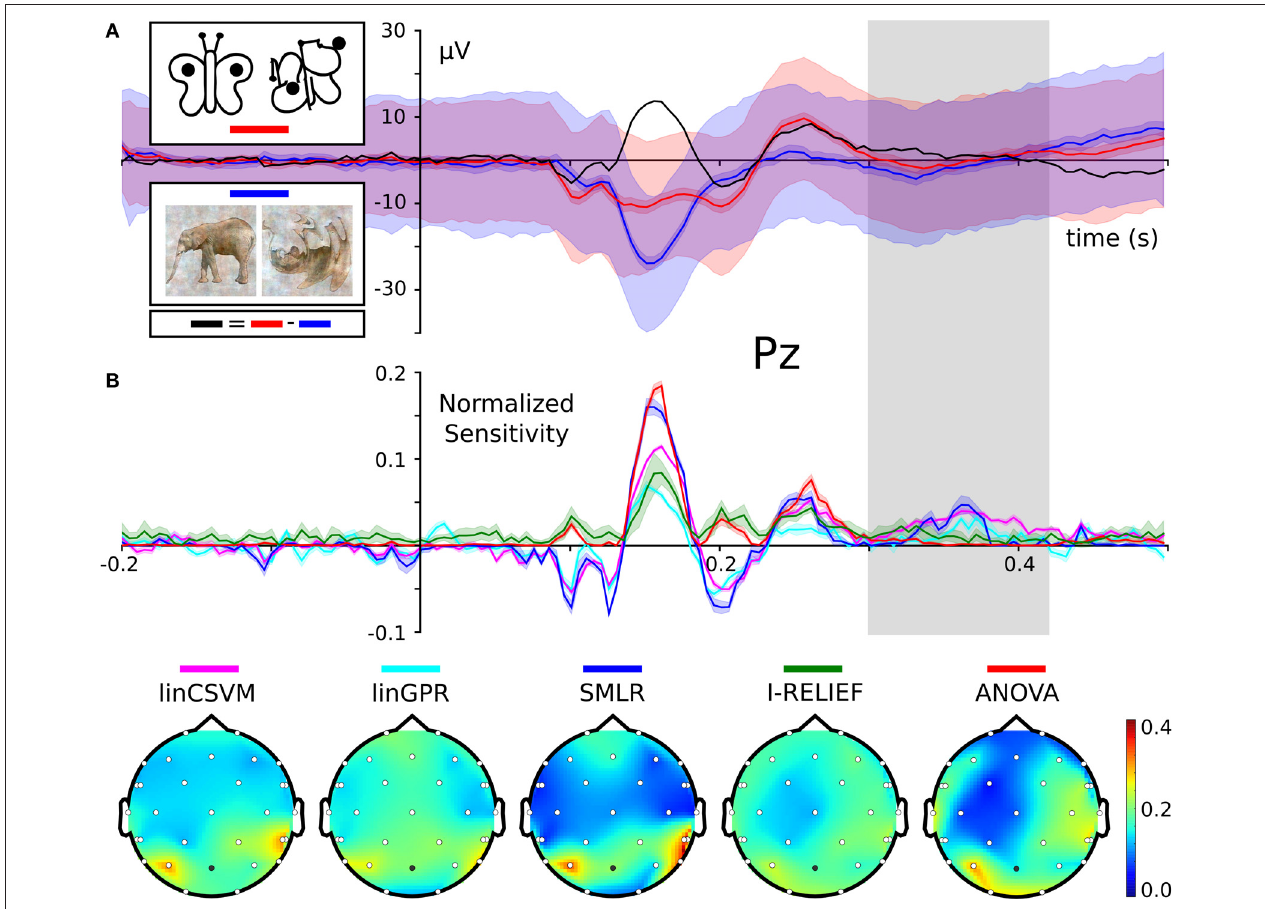
FIGURE 2 | Sensitivities for the classifi cation of color and line-art conditions. Panel (A) shows ERPs of each condition for electrode Pz . The light shaded area shows the standard deviation, the darker shade the 95% confi dence interval around the mean ERP of each condition. The black curve is the difference wave of both ERPs. The stimulus example images are from Fründ et al. (2008). Panel (B) shows feature sensitivity measures for the different methods. Sensitivities were normalized by scaling the vector norm of each sensitivity vector (covering all timepoints from all electrodes) to unit length. This allows for comparison of the relative weight each classifi er puts on each feature.